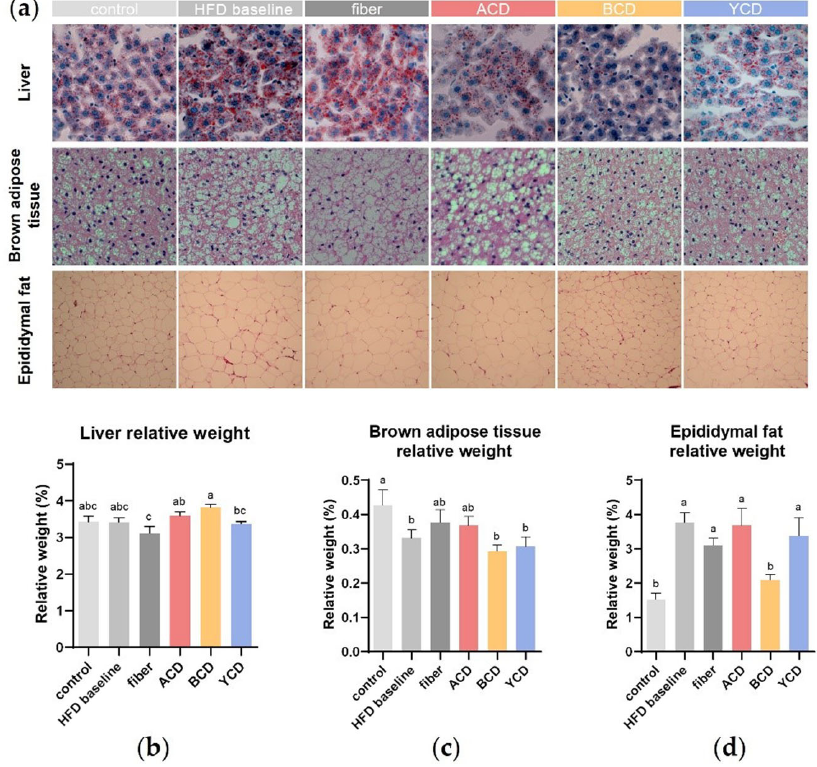
Figure 2. α -CD, β -CD, and γ -CD supplementation reduced fat accumulation in the liver, brown adipocytes, and epididymal adipose tissue. ( a ) Oil red staining of liver tissue sections and hematoxylin–eosin staining of brown adipose tissues and epididymal fat sections; ( b ) relative weights of the liver; ( c ) relative weights of brown adipose tissue; ( d ) relative weights of epididymal fat. n = 6. Control, low-fat diet; HFD baseline, high-fat diet without cellulose; fiber, high-fat diet; ACD, high-fat diet that replaced α -CD with cellulose; BCD, high-fat diet that replaced β -CD with cellulose; YCD, high-fat diet that replaced γ -CD with cellulose. Data are expressed as means ± SEM. Values not sharing a common superscript differ significantly among groups ( p < 0.05, ANOVA).